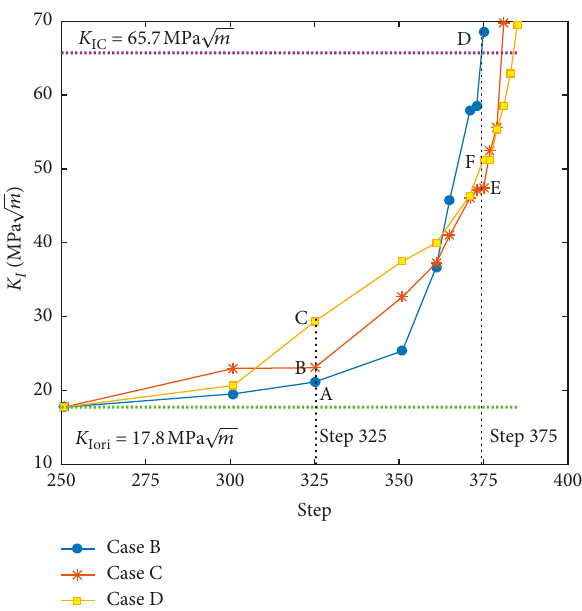
Figure 28: Time-varying curves of the stress intensity factor K I of steel wires corresponding to the cases in Figure 25. The original data of the table and figures in this section are provided in S3 File of the section “Supplementary